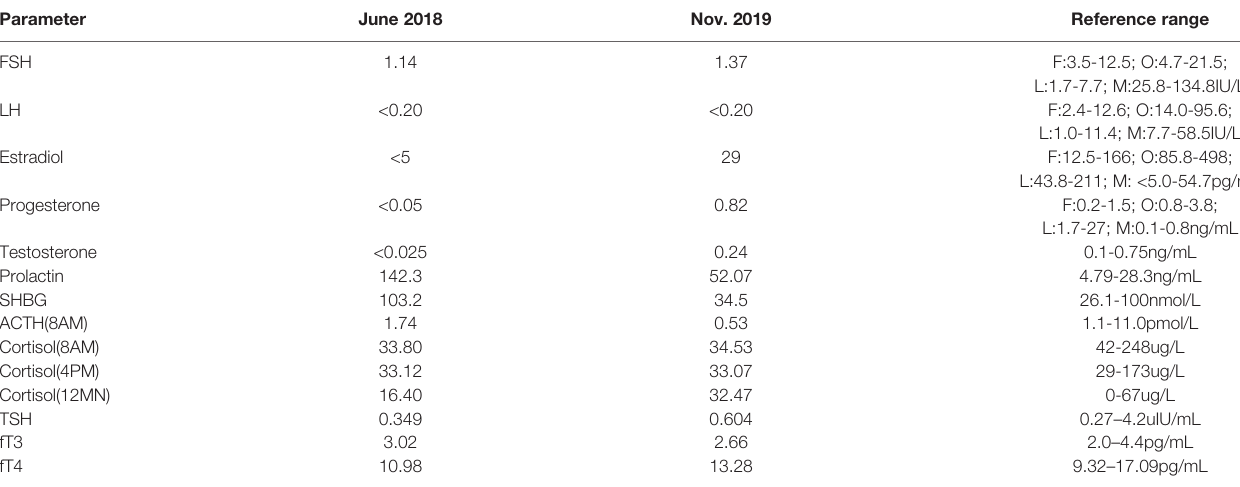
TABLE 1 | Hormone pro fi les of the